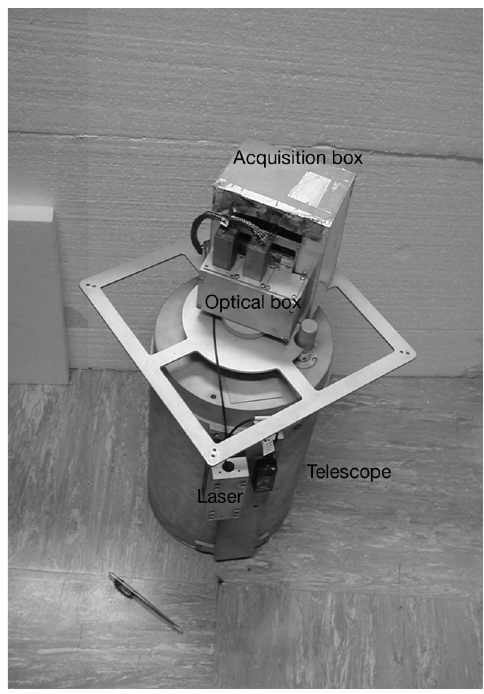
Fig. 3. MULID during the assembling phase. The squared structure on the top is necessary to sustain the carbon fiber and mylar reflecting shield. The op- tical box is mounted near the focal point of the tele-